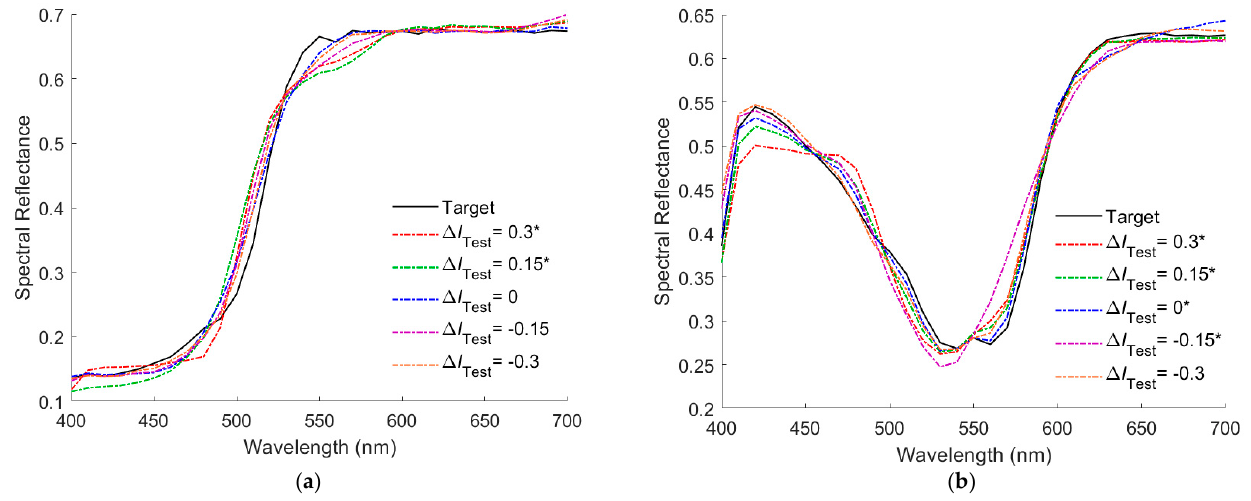
Figure 8. ( a , b ) showing the target reflectance spectra and the recovered reflectance spectra for the cases in Figure 7a,b, respectively. Outside samples are indicated with “*” in the legend.